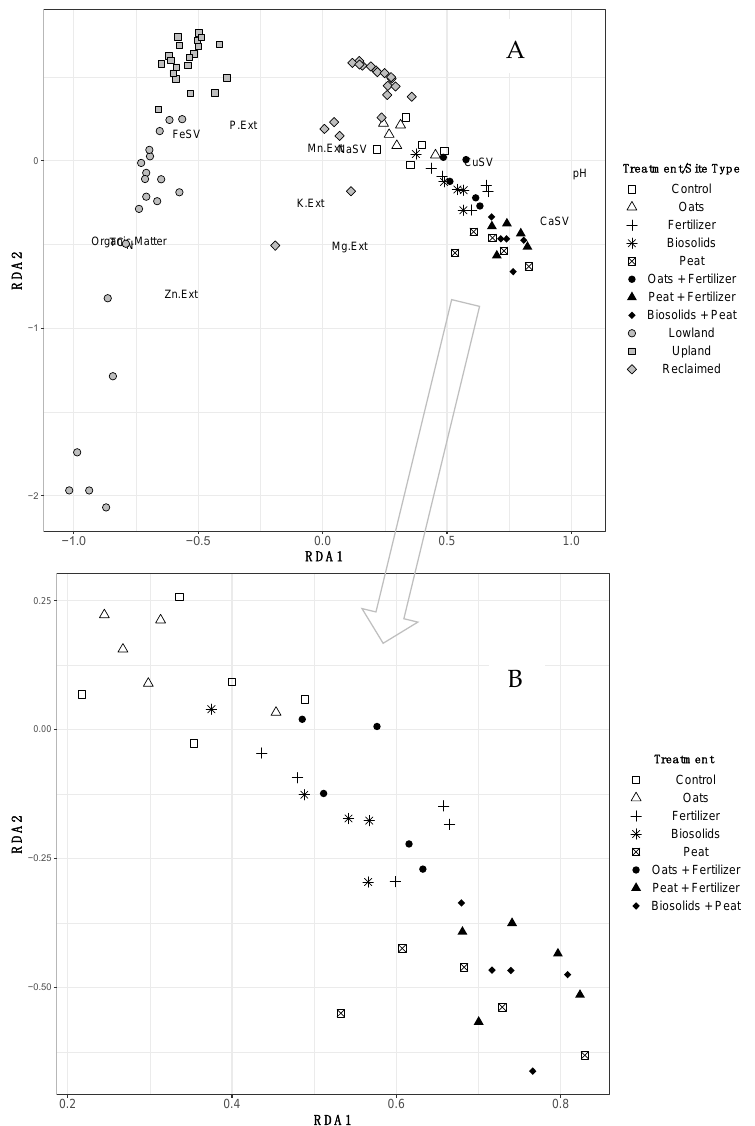
Figure 6. Vascular plant community assemblage ordination using RDA models within the amend- ment trial treatments and reference sites at the Detour Lake Mine property. ( A ) provides an ordination diagram that includes all sites (reference sites and treatment sites), while ( B ) provides an ordination diagram of the treatments only.